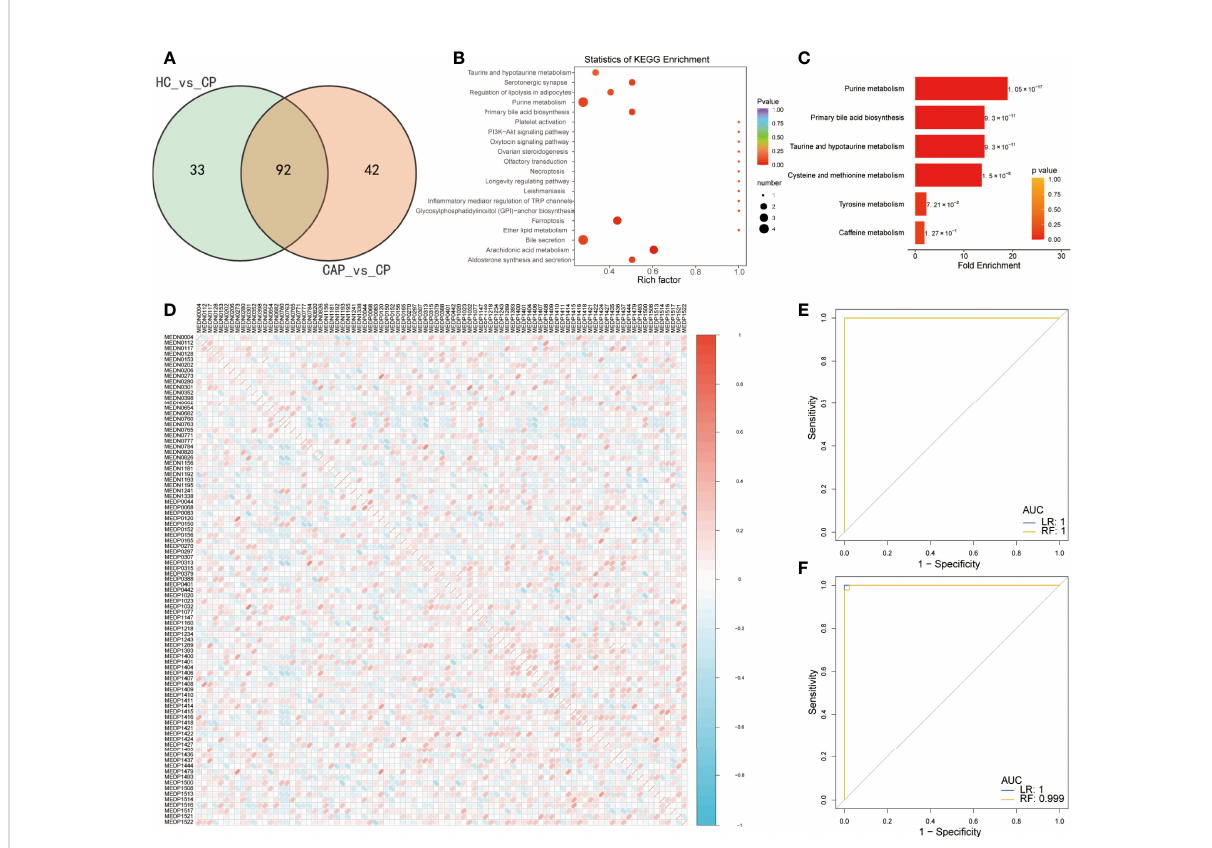
FIGURE 6 Predictive value of differentially expressed metabolites in predicting COVID-19 patients. (A) Venn diagram showing differentially expressed metabolites between two groups: healthy controls (HC) vs. COVID-19 patients (CP) and community-acquired pneumonia (CAP) vs. CP. (B) KEGG enrichment analysis of common differentially expressed metabolites. (C) Metabolite Set Enrichment Analysis (MSEA) of common differentially expressed metabolites. (D) Pearson correlation of 92 differentially metabolites between the two groups. Only the index of metabolites in the database is shown, and detailed metabolic information and classi fi cation are listed in Table S12 . (E) Receiver operating characteristic (ROC) curves of the two classi fi ers based on cross-validation in distinguishing COVID-19 patients (CP) from community-acquired pneumonia (CAP). (F) The ROC of the two classi fi ers based on the cross-validation in distinguishing CP from healthy controls (HC). LR, logistic regression; RF, random